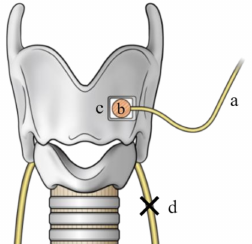
Figure 3. Nerve muscle pedicle (NMP) transplantation method. An NMP flap was made using an ansa cervicalis nerve branch ( a ) and a piece of the sternohyoid muscle ( b ); a window was opened in the thyroid cartilage ( c ) to expose the laryngeal muscle bundle; then, the NMP flap was securely implanted onto the laryngeal muscle through the window under microscopic guidance; ( d ) resected left recurrent laryngeal nerve (Citation: Ref. [30]).